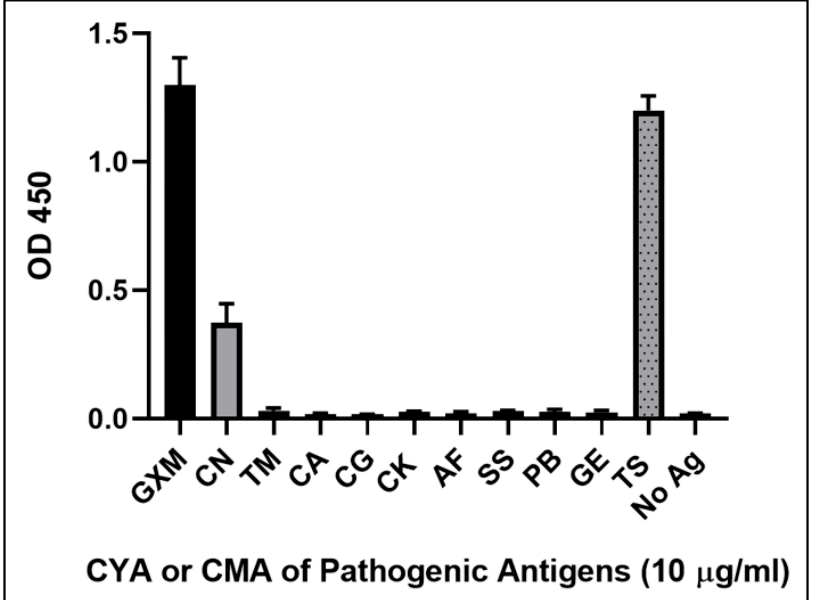
Figure 4. The various pathogenic fungal antigen and GXM capsular polysaccharide antigens were investigated for specificity by indirect ELISA . The absorbance measurement was observed at OD 450 nm with error bar represented as mean OD ± SD of triplicated determination. The concentration of GXM was 10 ng /mL. The concentrations of all pathogenic fungal antigens were 10 μ g /mL. The cytoplasmic yeast antigens (CYA) of pathogenic fungi were indicated C. neoformans strain H99, serotype A (CN), T. marneffei (TM), C. albicans (CA), C. glabrata (CG), C. krusei (CK), S. schenckii (SS), and Trichosporon sp. (TS). The cytoplasmic mycelial antigens (CMA) were A. fumigatus (AF), P. boydii ( PB ) , and Geotrichum sp . ( GE ).